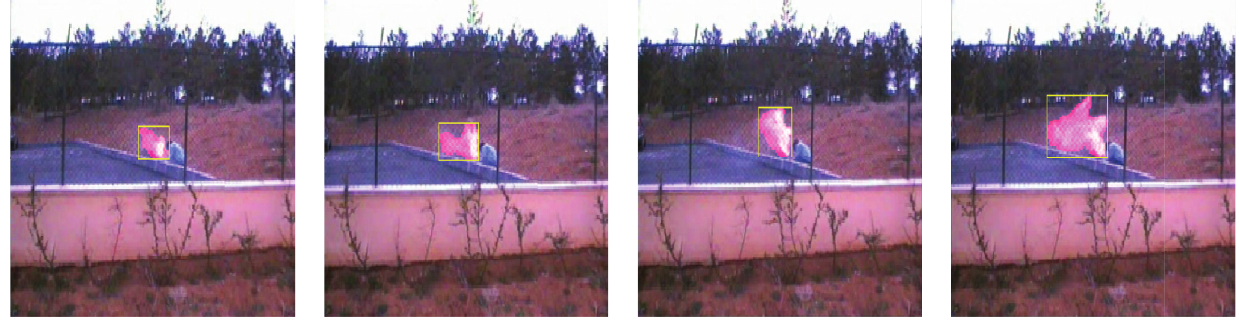
Figure 5: The results of several frames in three smoke videos from different